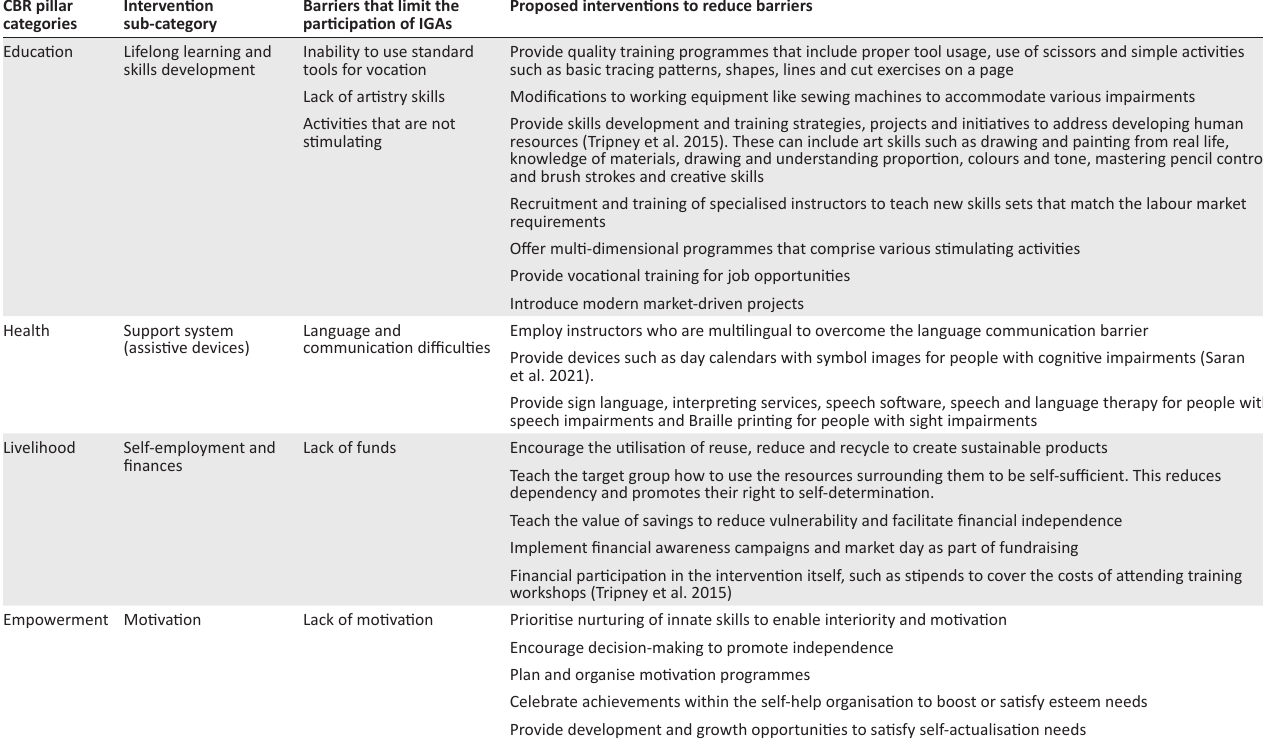
TABLE 2: Intervention strategies to counteract barriers that limit the participation of people with disabilities partaking in income-generating activities. CBR pillar Intervention categories